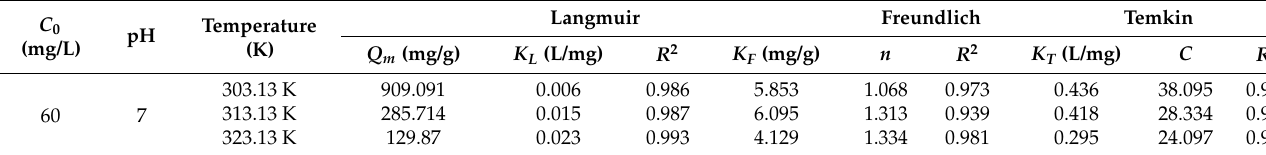
Table 1. Parameters of Langmuir, Freundlich and Temkin adsorption isotherm